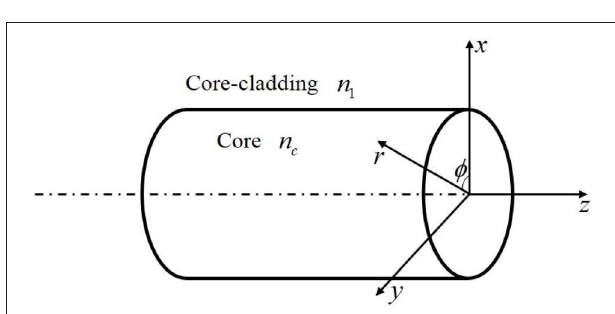
FIGURE 3 | Schematic diagram of the coordinates of the fiber in the cylindrical coordinate system.